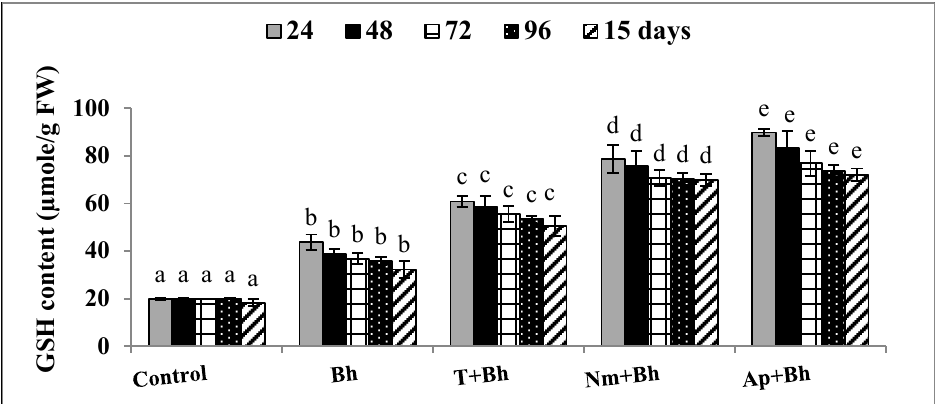
Figure 1. Effects of Bh application alone or in combination with different safener treatments on the GSH content of wheat plants. Data are presented as the mean ± SD ( n = 5). Bh: bromoxynil; T + Bh: tryptophan + bromoxynil; Nm + Bh: Nostoc muscorum + bromoxynil; Ap + Bh: Arthrospia platensis + bromoxynil. Different letters on the bars indicated a significant difference be- tween treatments at p <